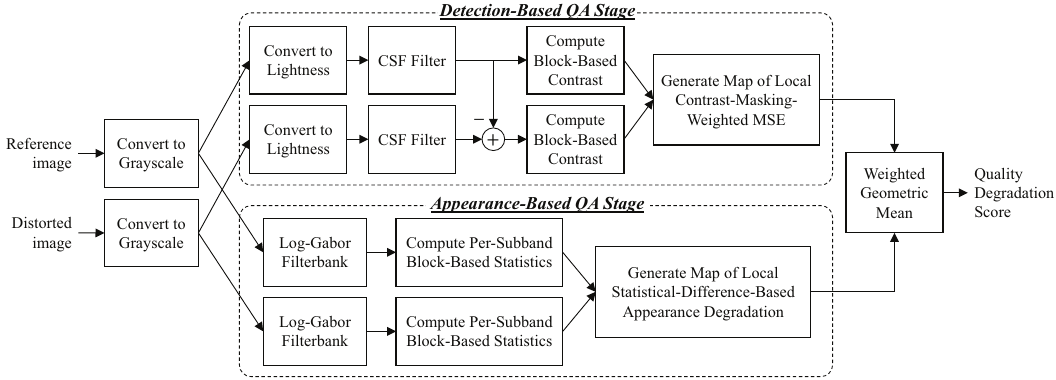
Figure 1. Block diagram of the MAD IQA algorithm. See Section 3 of the text for